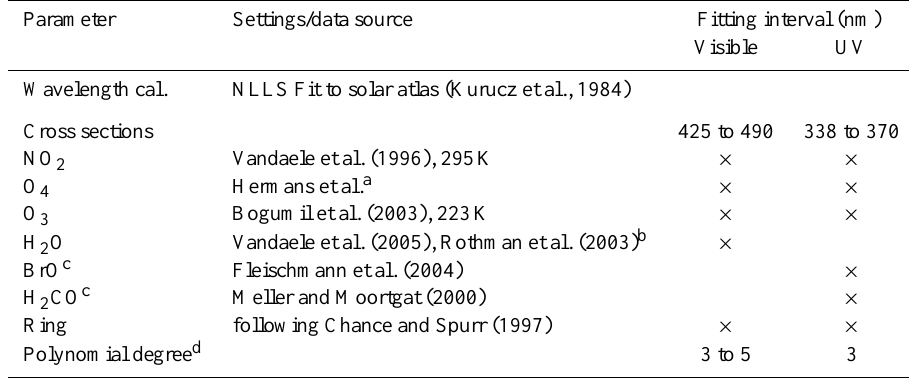
Table 2. Settings used for the analysis of spectra to produce slant columns of absorber. NLLS=non-linear least squares.